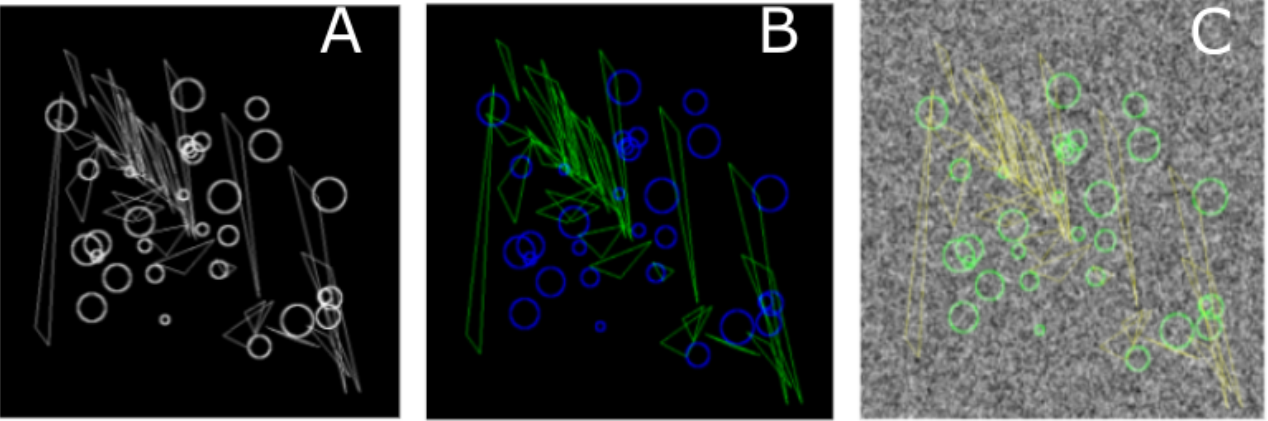
Figure 4. Circles/Triangles classification. ( A ) An image generated with variable size triangles and circles on black back- ground; ( B ) Individual objects are classified as triangles (green) and circles (blue) on noiseless background; ( C ) Individual objects are classified as triangles (green) and circles (blue) on noisy